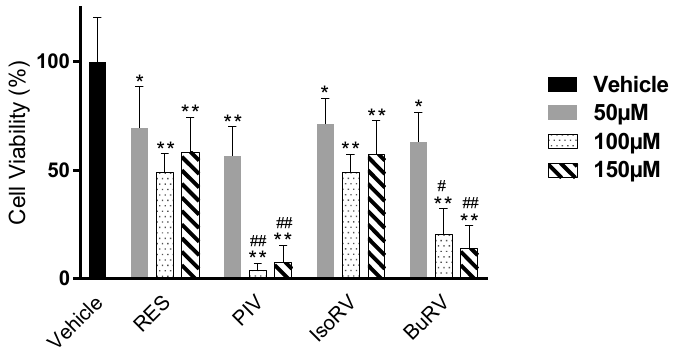
Figure 2. Resveratrol (RES) derivatives induce a decrease in breast cancer cell viability. MDA-MB-231 cells were treated with vehicle only (black), 50 μ M (gray), 100 μ M (dotted), or 150 μ M (striped) of resveratrol (RES), 4 ′ -pivalate resveratrol (PIV), 4 ′ -isobutyrate resveratrol (IsoRV), or 4 ′ -butyrate resveratrol (BuRV) for 48 h, and subsequently measured for viability with MTT. The data are representative of three biologic replicates conducted in triplicate. * indicates p < 0.05 compared to the vehicle control, ** indicates p < 0.01 compared to the vehicle control, # indicates p < 0.05 compared to RES at the equivalent concentration, and ## indicates p < 0.01 compared to RES at the equivalent concentration.